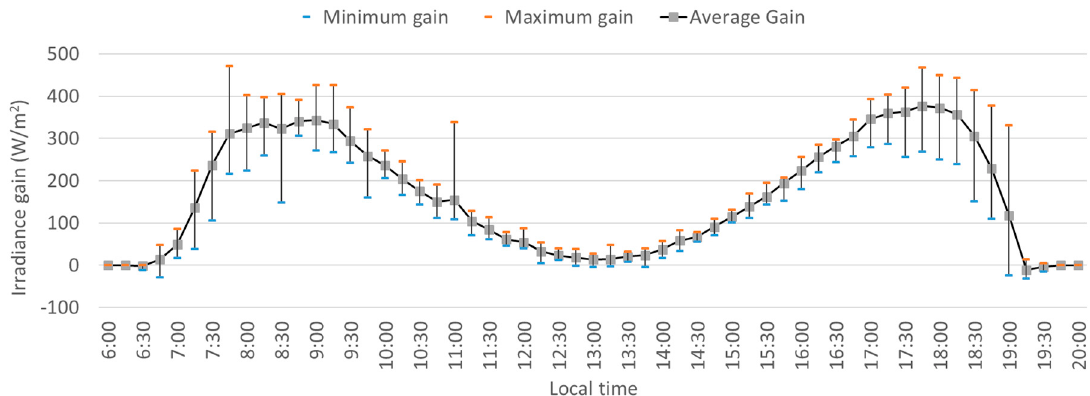
Figure 15. Analysis of average irradiance gains of the tracking system compared to the fixed one over the day for the 9-days experimental campaign and, difference between the maximum and minimum gains represented by the bars.